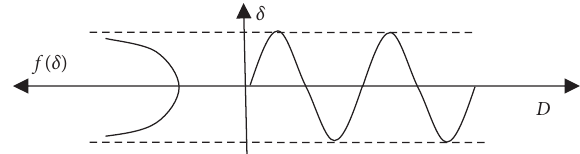
Figure 3: Regularity and randomness of periodic error.